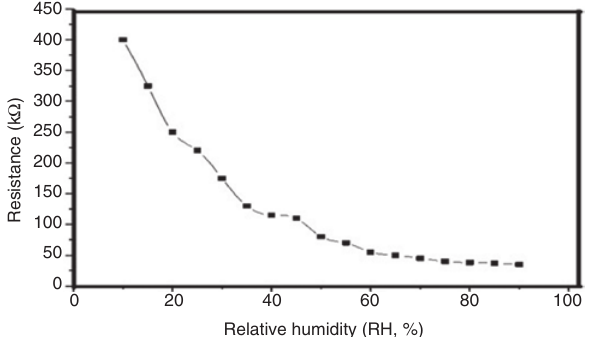
Figure 8: Variation of resistance with RH for maximum conducting